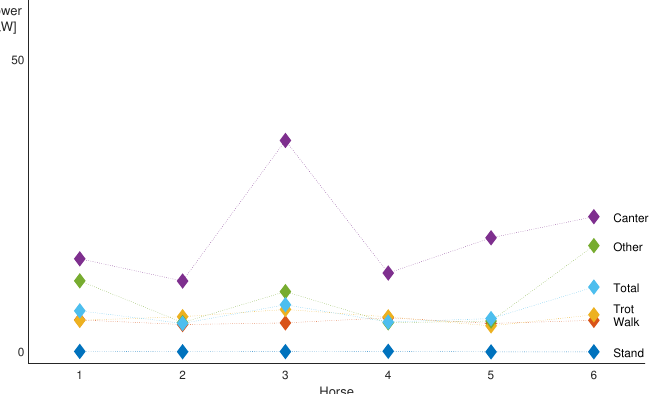
Figure 10. Harvested power for the four different horses. The limping horse (3) has a significant higher power generation during canter than the other